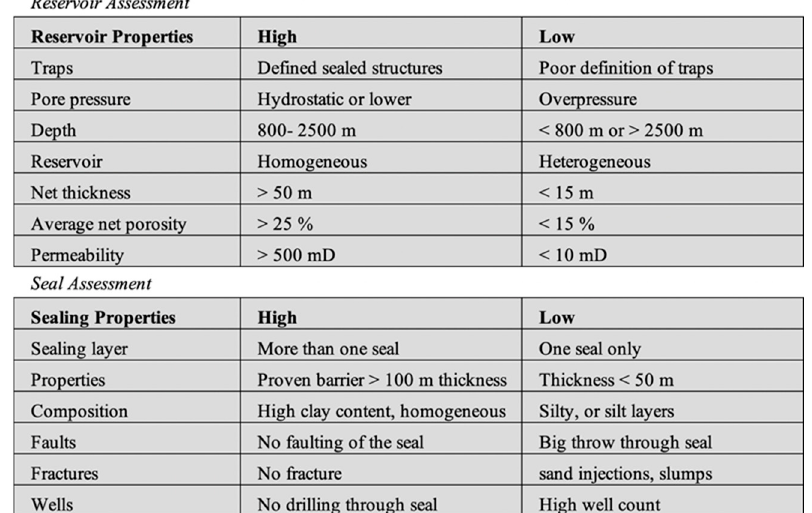
Figure A1. Guide ranges for principle attribute quality [71,82].